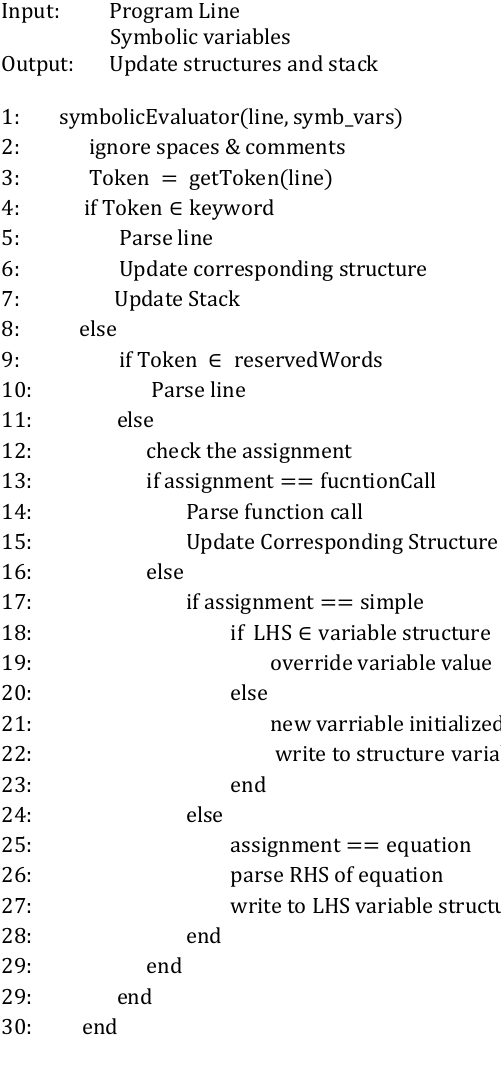
Figure 3 Symbolic Evaluator